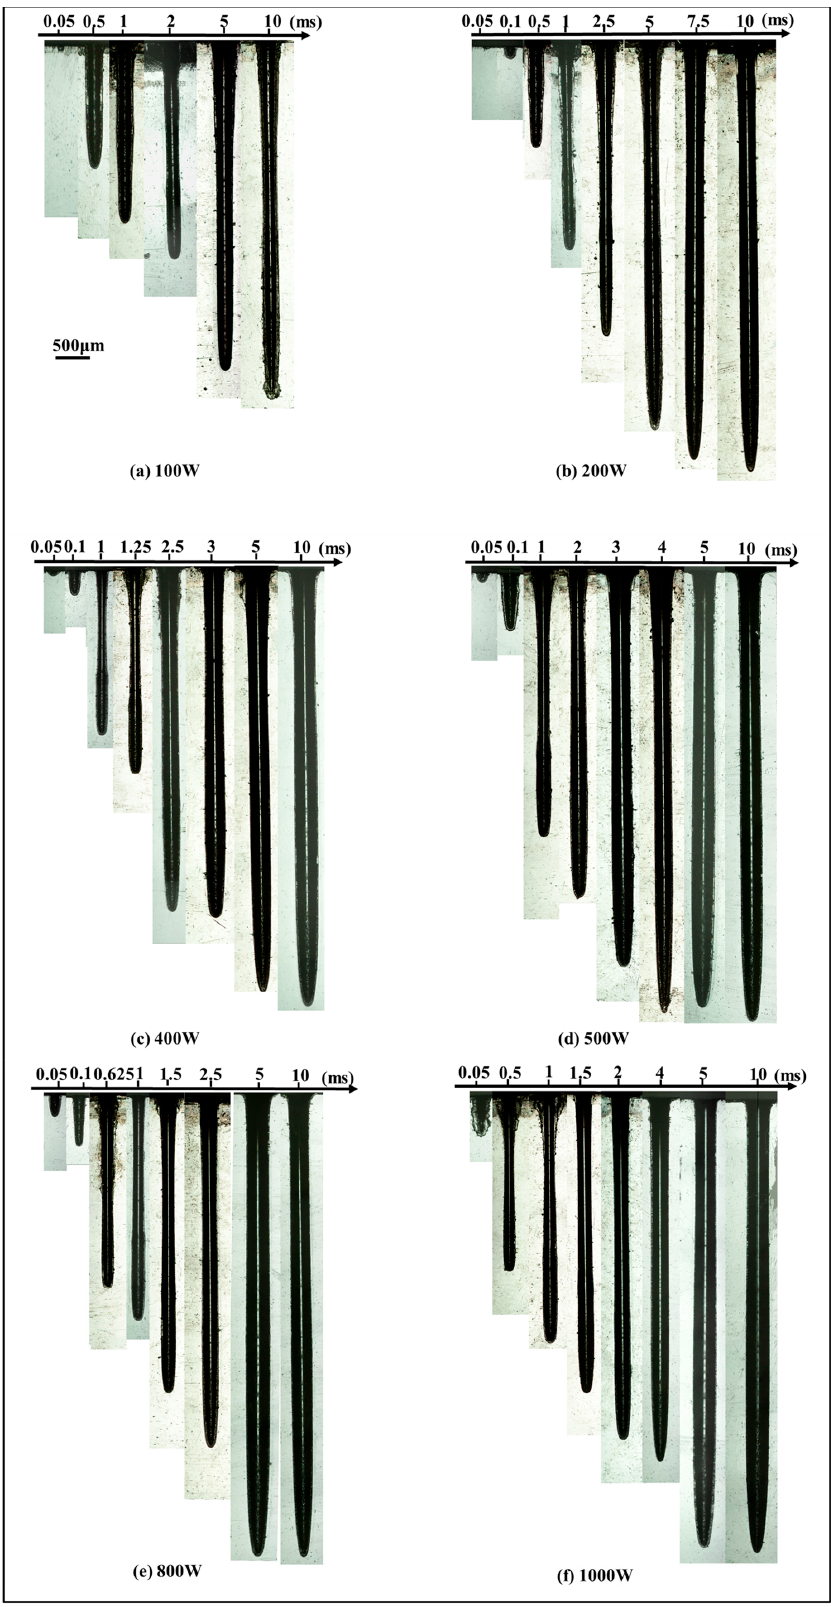
Figure 5. Sectional morphology of the hole under different pulse widths with the peak power